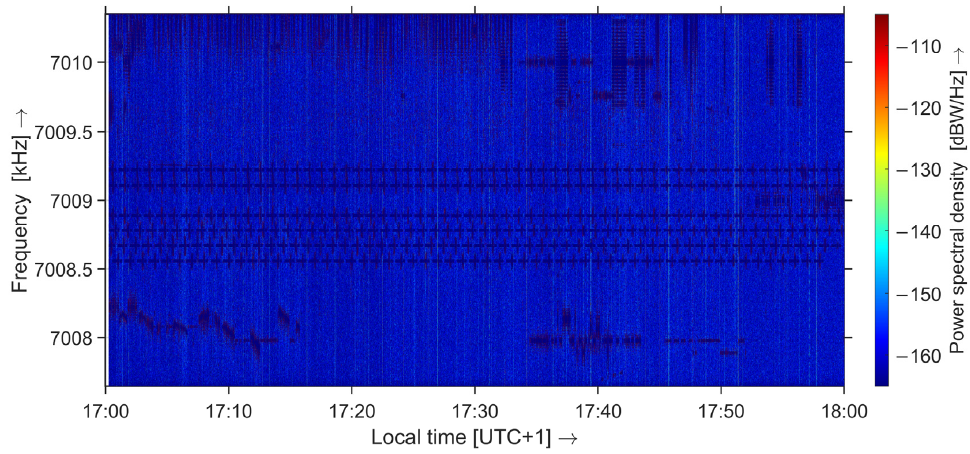
Figure 8. In each FFT, the frequency bins exceeding the threshold are removed. The remaining bins contain the background noise, which may vary in time.